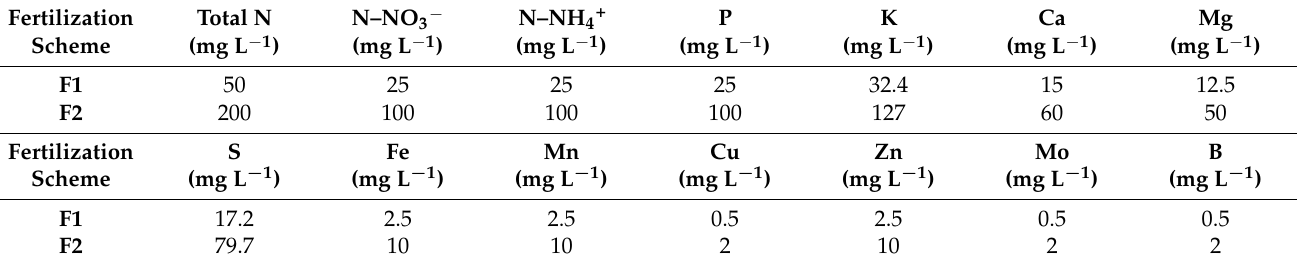
Table 3. Fertilization schemes